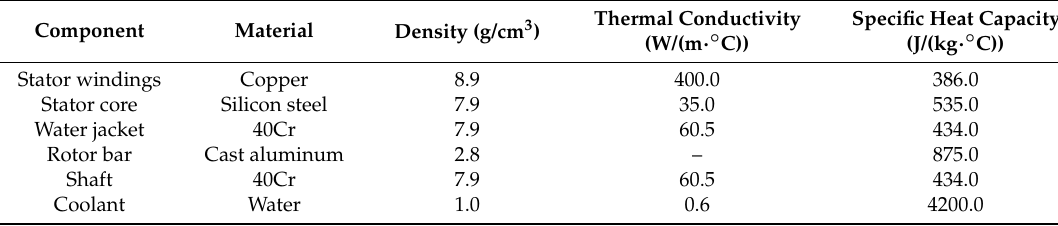
Table 2. Parameters of materials of the model.